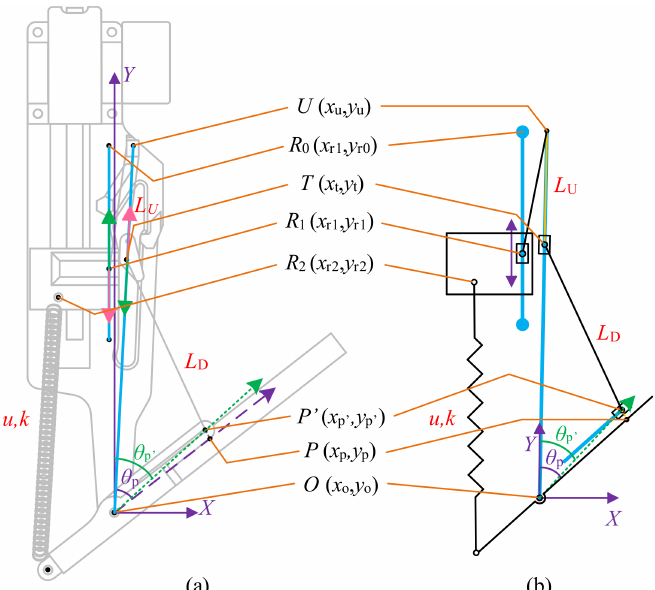
Figure 4. Geometric model describing transmission relationship: ( a ) practical realization; ( b ) ab- stracted model. The thick blue lines indicate the orbit of the associated sliding dot. Meanings of dots: R 1 , hanging point of upper string on rectangle slider (RS), whose orbit is expressed in blue; R 2 , hanging point of spring on RS; U, string hole; T, triangle slider (TS); P (cid:48) , position where lower string passes through the pole; P, intersection point of the extension cord of lower string and the direction of the pole (from dot O). Meanings of constants and variables: k , stiffness coefficient of serried springs; u, length of springs, L D , length of lower string, equals d OP in value; L D , length of upper string, approximately equals d UR1 + d TR1 in value; θ P , angle between y axis and OP; d OP (cid:48) , angle between y axis and